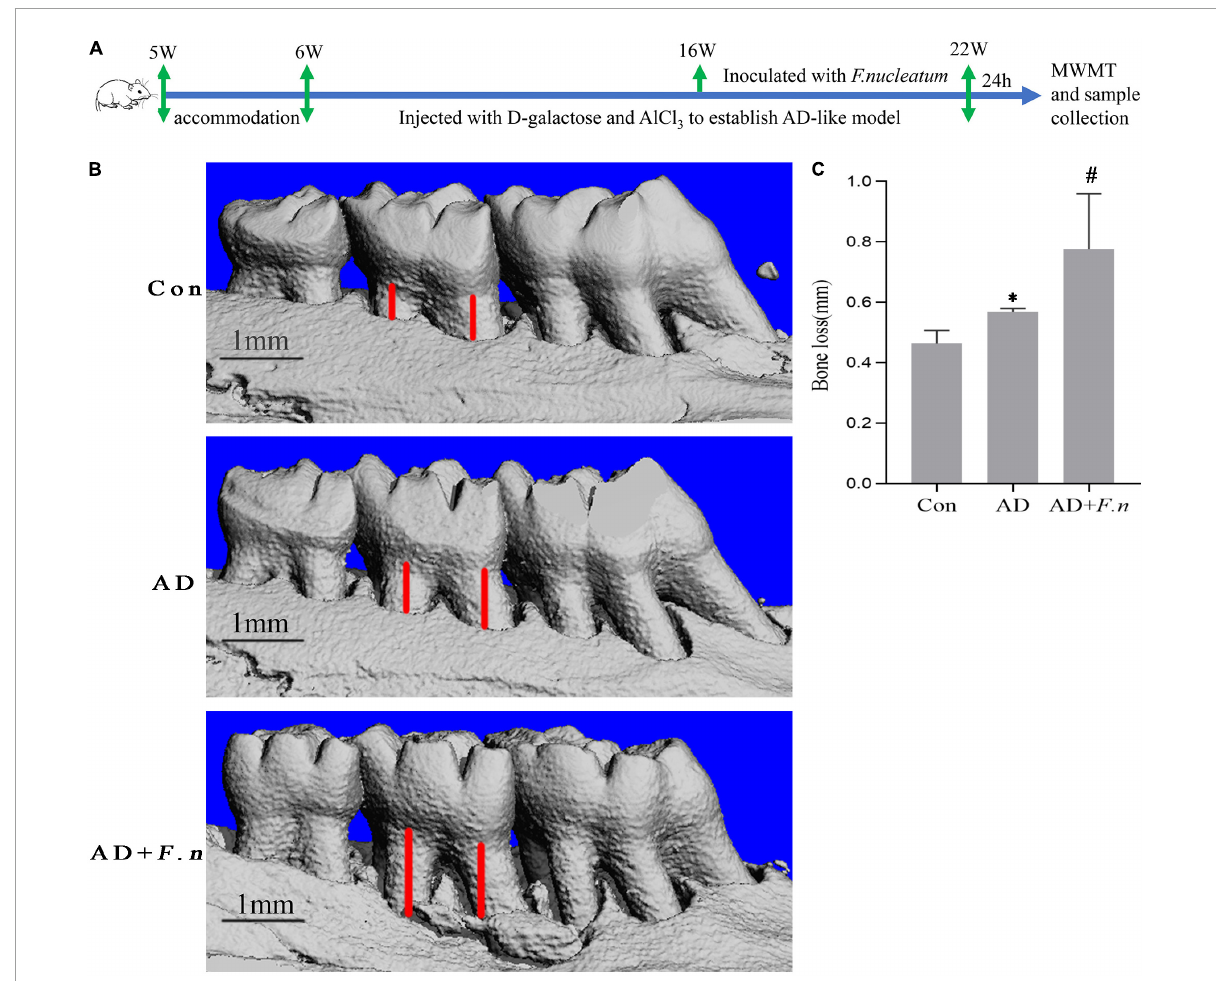
FIGURE1 Micro-CT showed alveolar bone loss in each group ( n = 4–5). (A) Flow chart. (B) Three-dimensional view of bone resorption. (C) Alveolar bone loss in each group. Data presented as mean ± SEM. * P < 0.05 vs. Con group, # P < 0.05 vs. AD group, indicates statistically significant